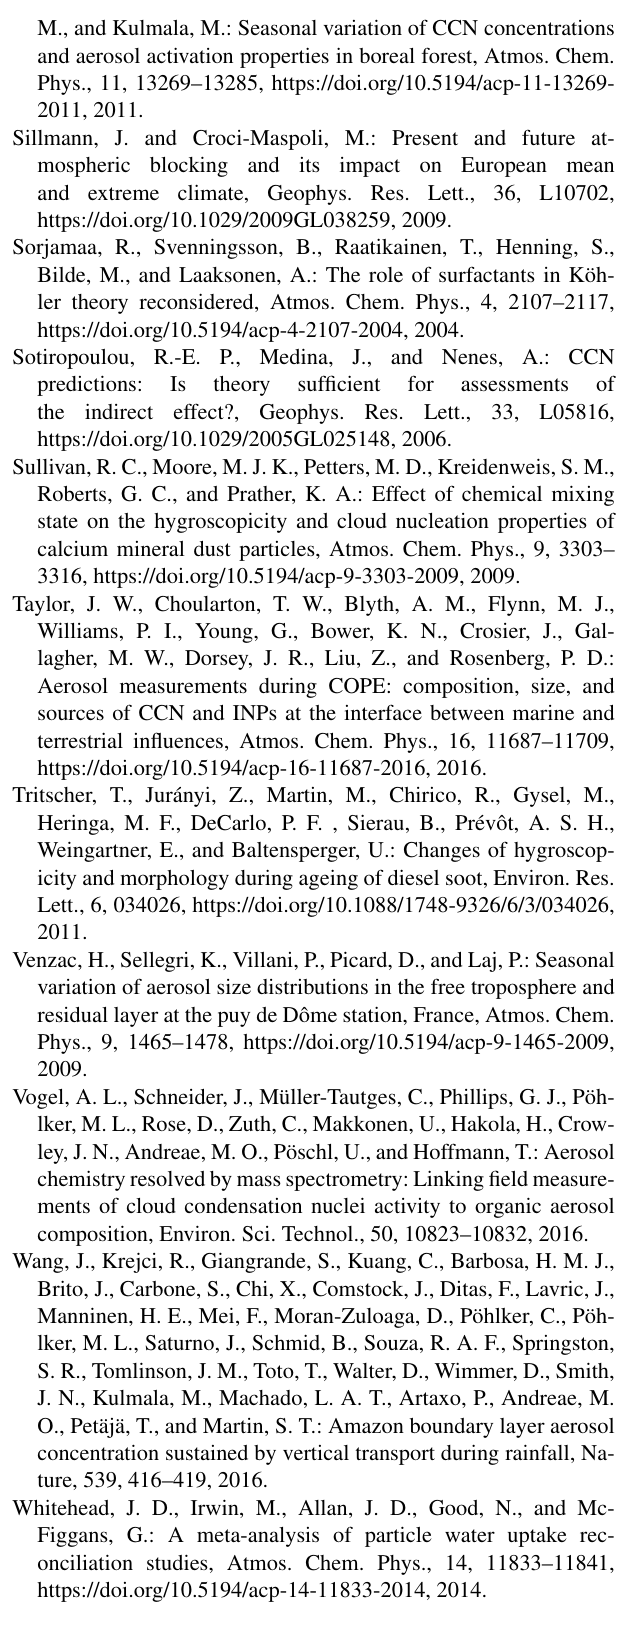
Figgans, G.: A meta-analysis of particle water uptake